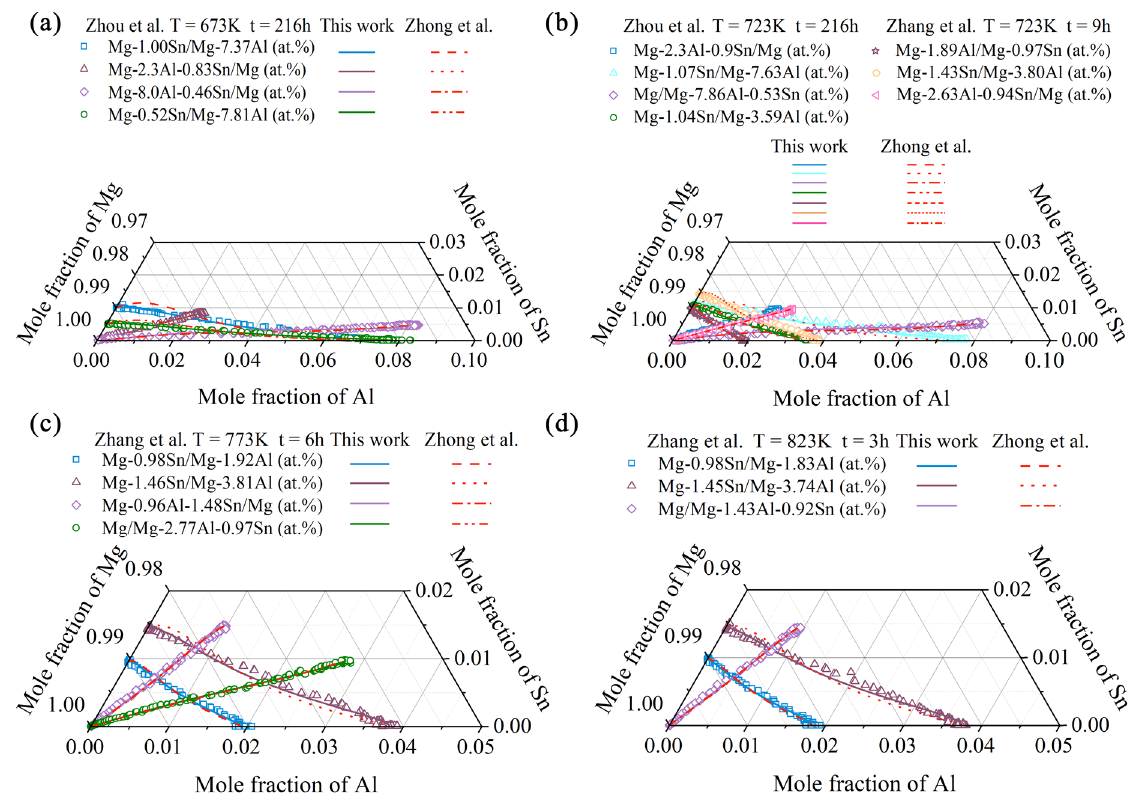
Figure 9. Model-predicted composition–distance profiles of the different hcp Mg–Al–Sn diffusion couples annealed at ( a – c ) 723 K for 9 h and ( d – f ) 823 K for 3 h from the present atomic mobilities (solid lines) compared with these of Zhong et al. [32] (dashed lines) and the experimental data [34] (in symbols).